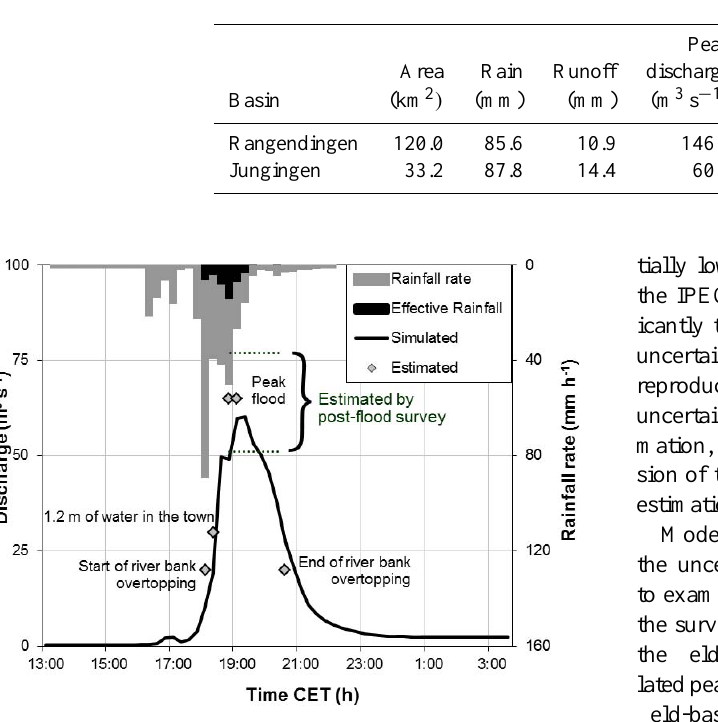
Fig. 12. Flood hydrograph simulation in Jungingen. The dia- monds indicate the reported timing of flooding features from eye-